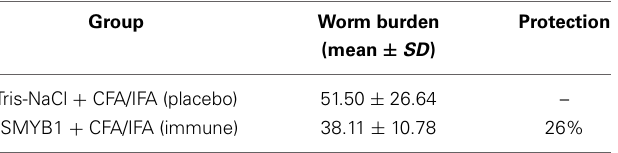
Table 1 | Worm burden and protection level in mice vaccinated with the rSMYB1 protein.